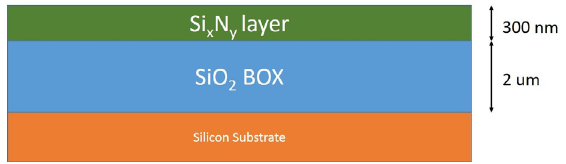
Figure 12. Schematic representation of wafer compositions.